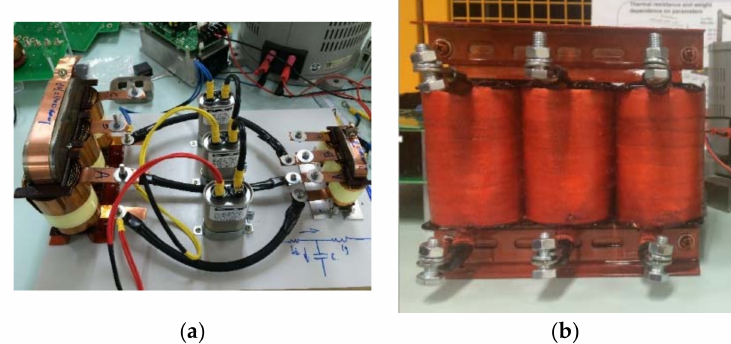
Figure 6. Inductor design in the LCL filter: ( a ) copper foil-wound, 4.5 kg; ( b ) copper wire-wound, 6.5